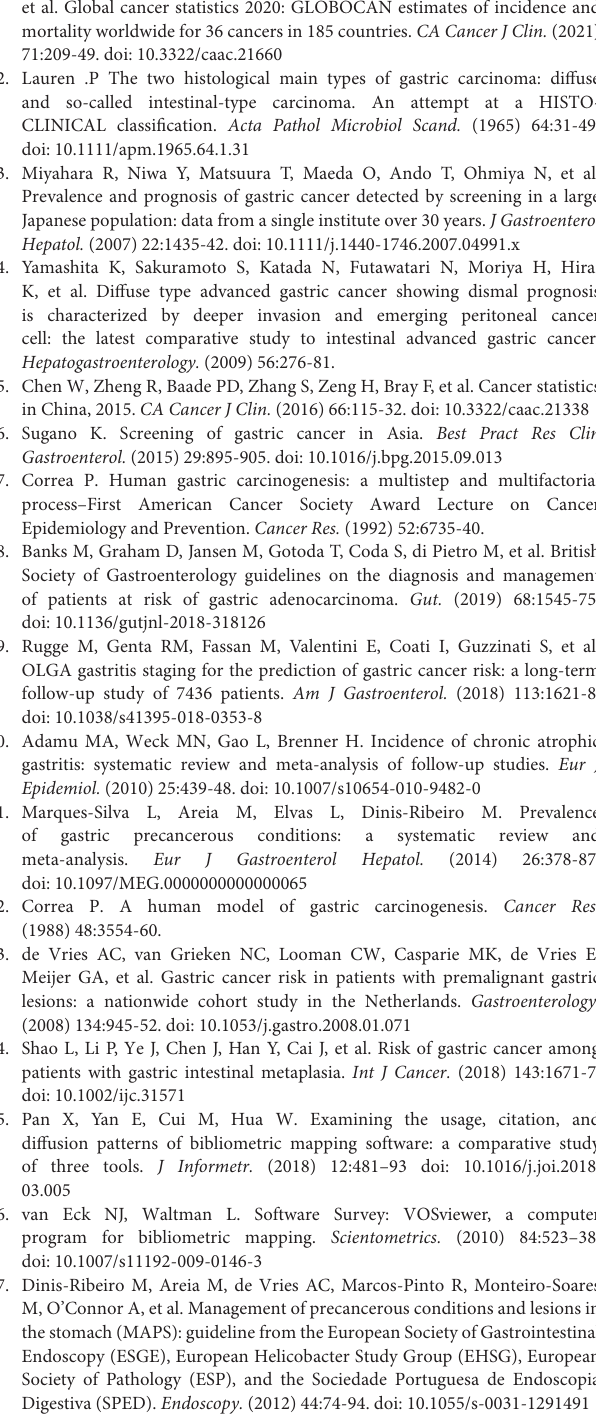
Supplementary Figure 3 | The Sankey Plot representing the relationships among author’s keywords, authors, and cited